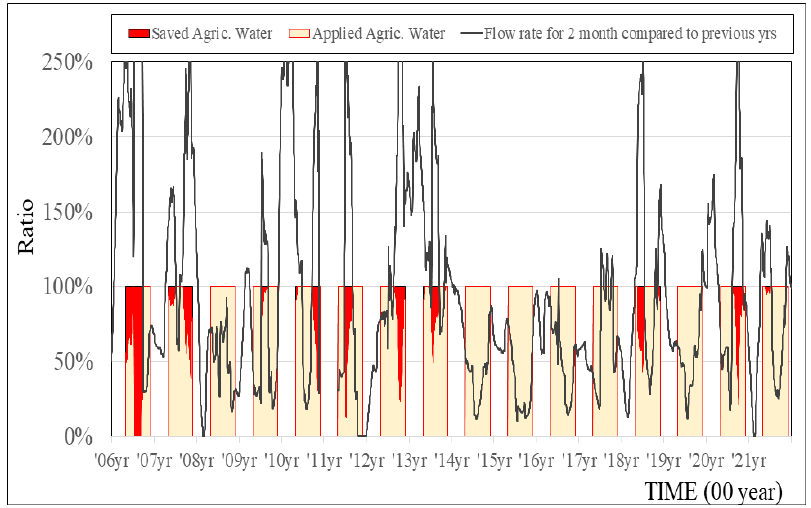
Figure 7. Time series plot for agricultural water supply based on the URP threshold curve; red bar indicates the amount of agricultural water saved.